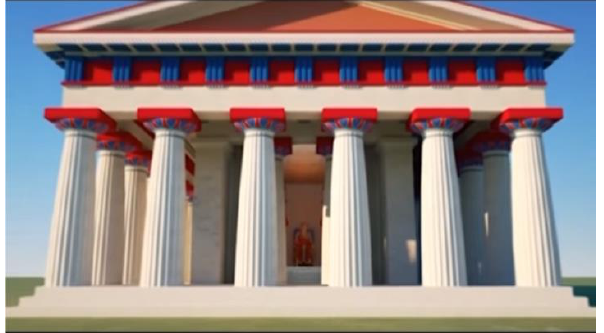
Figure 5. Chromatic reconstruction created for the exhibition “Colori nell’antica Paestum. Vita dei colori e colori della vita”. Archaeological Museum of Paestum (Link at the video: https://www.youtube.com/watch?time_continue=11&v=JlCdr5hYb0Q). Copyright © Archaeological Museum of Paestum.